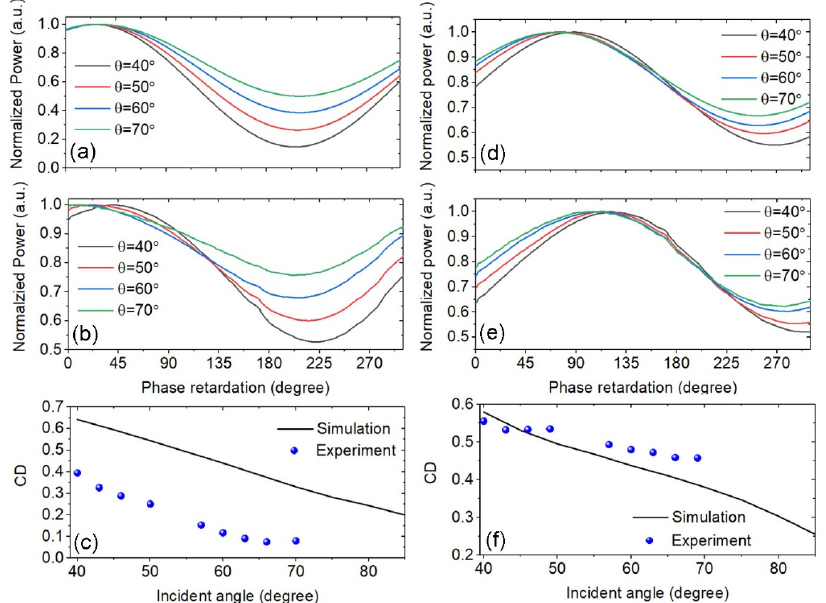
Figure 5. The numerical results for diffraction power versus phase retardation of LCVR in ( a , b ); the measured diffraction power in ( c , d ); the angular dependence of CD values in ( e , f ); ( a – c ) the incident beam is in the xz plane; ( d – f ) the incident beam in the yz plane.